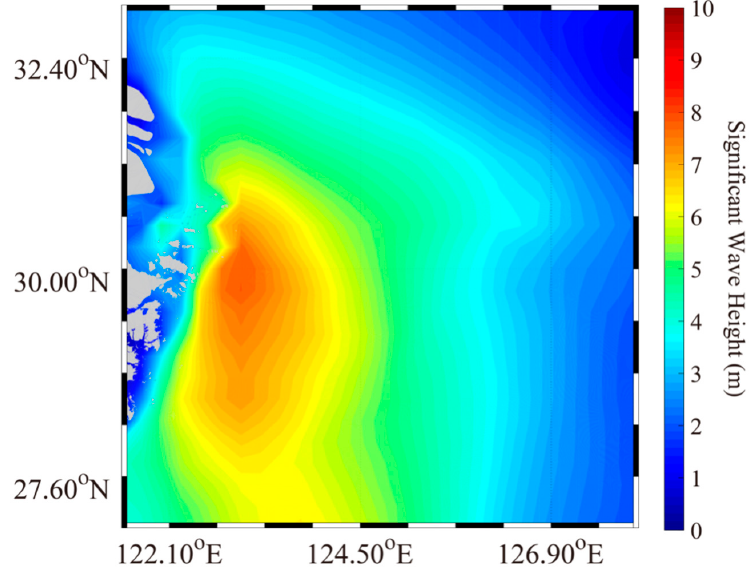
Figure 11. Significant-wave-height maps from the SWAN model at 14:00 UTC on 22 September 2014.